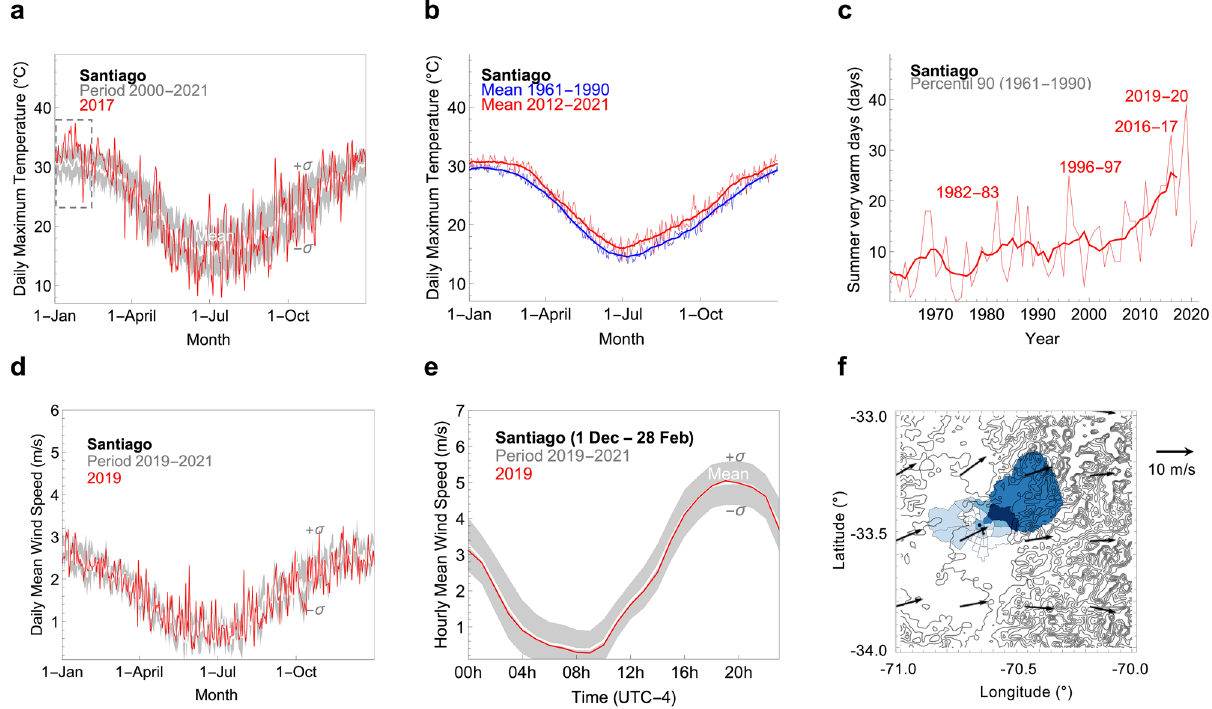
Figure 2. While rising temperatures affect all inhabitants, wind direction makes the ozone pollution burden heavier for wealthy northeastern communities. ( a ) Daily maximum temperature in Santiago. For each day of year (DOY), we formed datasets using daily maximum temperatures over the period 2000–2021. The mean (white line) and standard deviation (bounds of the gray shading) of these datasets are shown in the plot. The daily maximum temperature for 2017 is also shown (red line). The dotted rectangular box highlights a period of very warm days in January 2017. ( b ) Daily maximum temperature in Santiago averaged over two periods: 1961–1990 (blue line) and 2012–2021 (red line). Bold lines correspond to the 30-day centered moving averages. ( c ) Progress of summer ‘very warm” days in Santiago over the period 1961–2021. Bold line corresponds to the 7-year centered moving averages. We consider a summer day to be “very warm” if the corresponding maximum temperature falls above the 90th percentile of the daily base climatology (built up by using daily maximum temperatures measured over a 30-year base period 1961–1990; see “Methods”). ( d ) Daily average wind speed in Santiago. For each day of year (DOY), we formed datasets using values of the daily average wind speed over the period 2019–2021. The mean and standard deviation (σ) of these datasets are shown in the plot. The daily average wind speed for 2019 is also shown (red line). ( e ) Hourly average wind speed in Santiago. For each hour, we formed datasets using values of the hourly average wind speed over the period 2019–2021. The mean (white line) and standard deviation (bounds of the gray shading) of these datasets are shown in plots. ( f ) Vector array map showing 10-m summer wind speed and direction averaged from 13 to 20 h UTC over the period 2011– 2020. Air temperature and wind speed are from the weather station that the Chilean Weather Service (DMC) operates since early twentieth century downtown Santiago; measurements are available at https:// clima tolog ia. meteo chile. gob. cl/ appli cation/ diario/ visor DeDat osEma/ 330020. In the case of the vector array map, data from ERA5 46 were used. Plots were generated using Python’s Matplotlib library 50